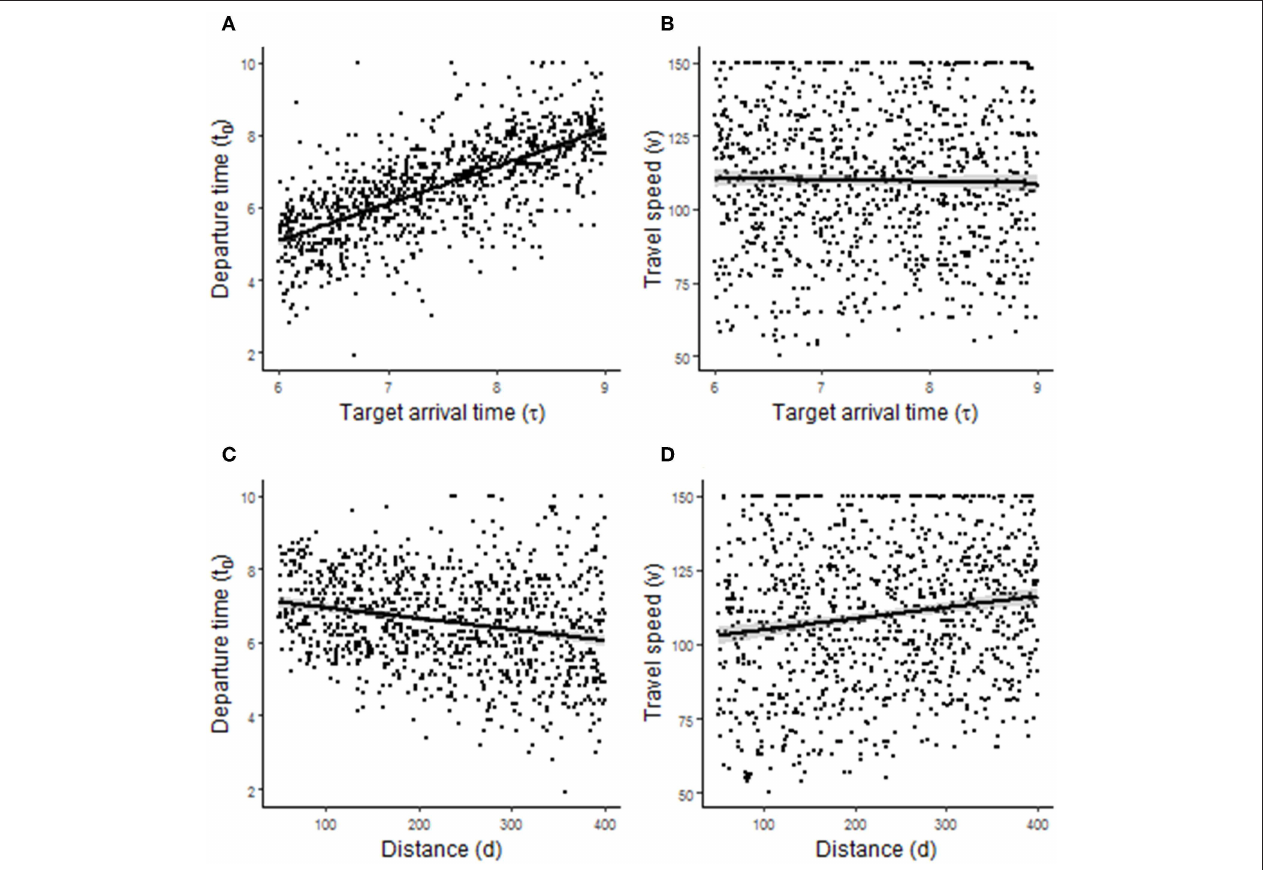
FIGURE 3 | Predictions arising from randomized simulations of the commuting model. (A,B) Show the effect of target arrival time τ on departure time t 0 (hours since midnight) and travel speed v (km · h − 1 ), respectively. (C,D) Show the effect of commuting distance d on t 0 and v , respectively.